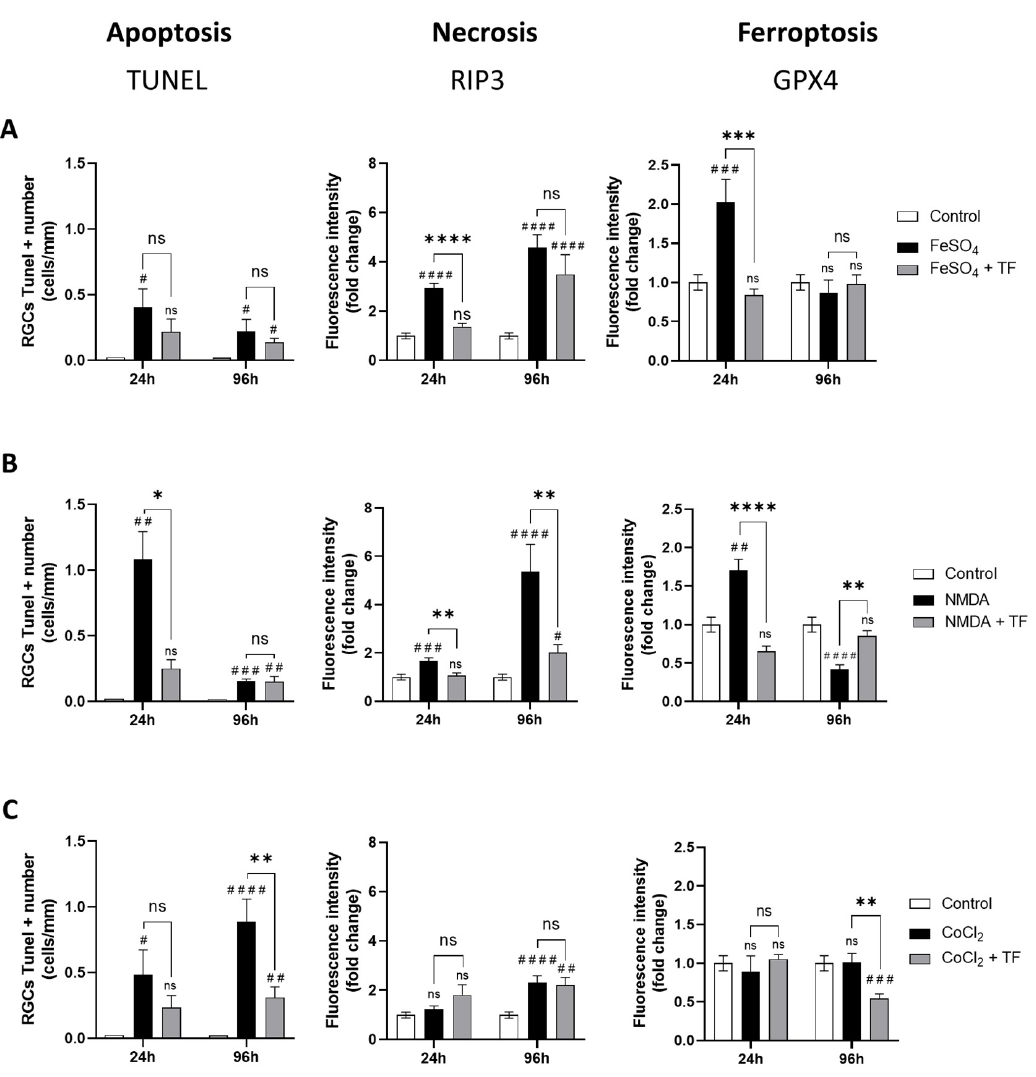
Figure 3. Transferrin protects RGCs against different cell-death mechanisms. Activation of apoptosis, necrosis, or ferroptosis in rat retinal explants exposed to FeSO 4 ( A ), NMDA ( B ) or CoCl 2 ( C ) in presence or in absence of TF was monitored by, respectively, the quantification of TUNEL-positive RGCs and by the change in RIP3 or GPX4 immunostaining intensity in RGC layer compared to controls (fold change). ( A ) FeSO 4 induces a significant increase in RIP3 and GPX4 expression which was limited or prevented by co-treatment with TF. ( B ) NMDA increases the number of TUNEL- positive cells as well as RIP3 and GPX4 expression. TF prevents increase in all three markers. ( C ) CoCl 2 induces a significant increase in the number of TUNEL-positive cells which was prevented by TF. Data represent means ± SEM, n = 4–10 explants per condition. Statistical analysis was performed with Kruskal–Wallis and Dunn’s tests for multiple comparisons. ns, not significant; # p < 0.05; ## p < 0.01; ### p < 0.001; #### p < 0.0001 compared to control. ns, not significant; * p < 0.05; ** p < 0.01; *** p < 0.001; **** p < 0.0001 compared to stress condition.